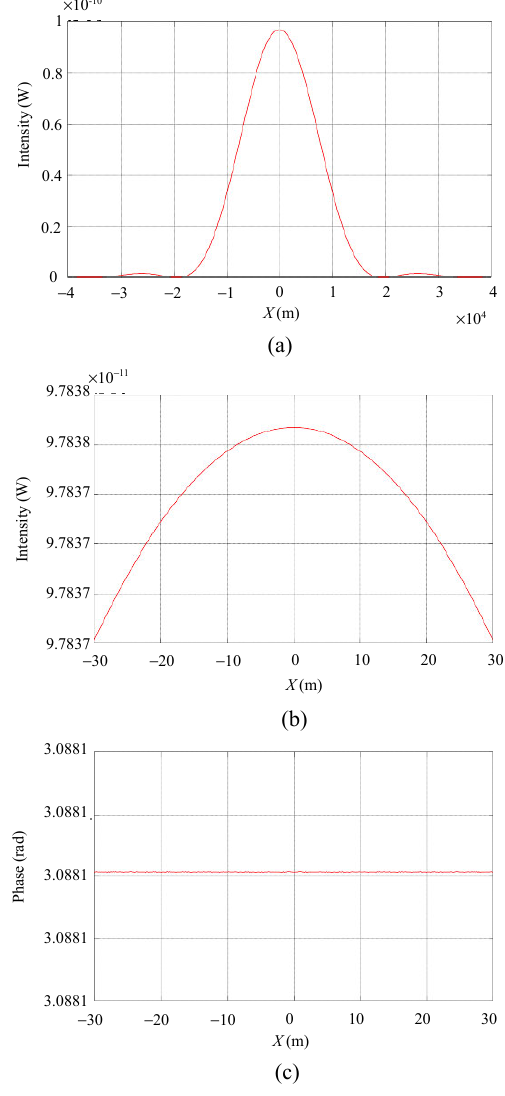
Fig. 1 Fair-field wavefronts: (a) the diffraction intensity distribution of the far field, (b) the intensity within a radius of 30 m that are vertical to the line of sight, and (c) the phase within a radius of 30 m that are vertical to the line of